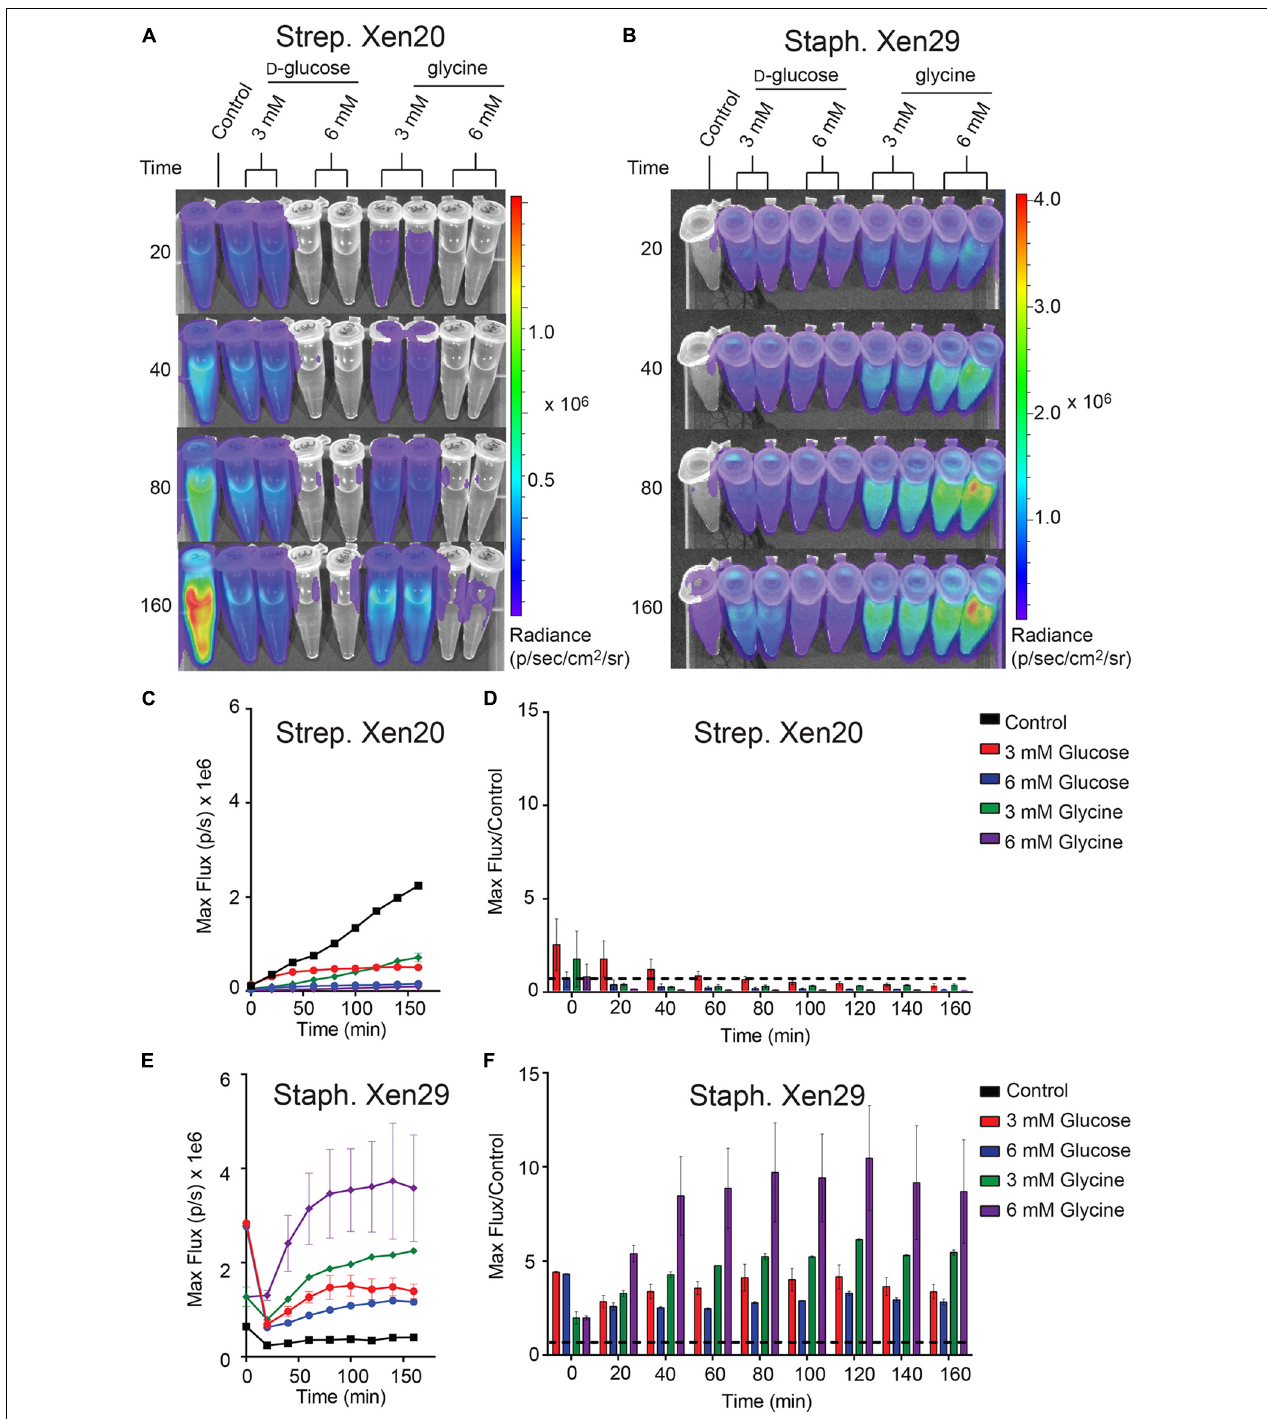
FIGURE 4 | The effect of monosaccharides on bioluminescence production by Gram-positive pathogen. (A) Representative time course of Strep . Xen20 or Staph. Xen29. For all samples, cells were grown to the stationary phase then diluted in fresh phosphate-buffered saline (i.e., control) supplemented with either D -glucose or glycine as indicated. (B) Similar time course for Staph . Xen29. (C) Quantification of the Strep . Xen20 luminescent signal from (A) . (C,D) Quantification of luminescent signal from samples shown in panel (A) for Strep . Xen20 represented as either the maximum rate of photons generated (shown on the left as max flux) or as the relative maximum signal normalized to the control (shown on the right as flux/control) displayed as a function of time. The black dashed line indicates a ratio at the threshold of 1.0. (E,F) Similar quantification of panel (B) for Staph . Xen29. All samples are color coded as indicated and the experiment performed, as shown in the “Materials and Methods”